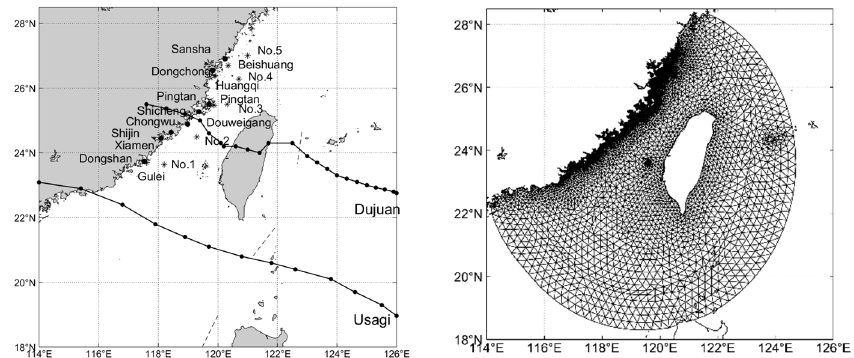
Figure 1. Location of Dazuo Seawall, the tidal gauge of Chongwu.